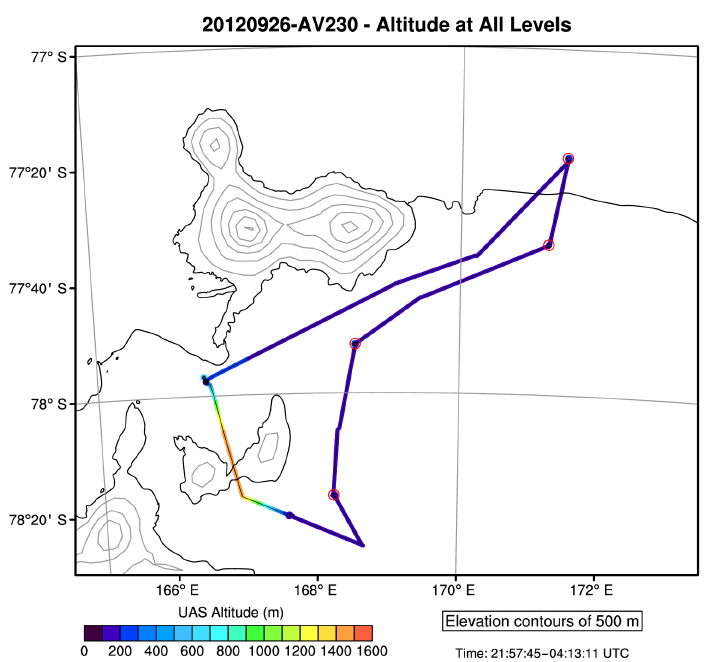
Figure 4. Map of Ross Ice Shelf and Ross Sea flight 26 September 2012 AV230. Color shading along flight path indicates flight altitude. Red circles indicate location of